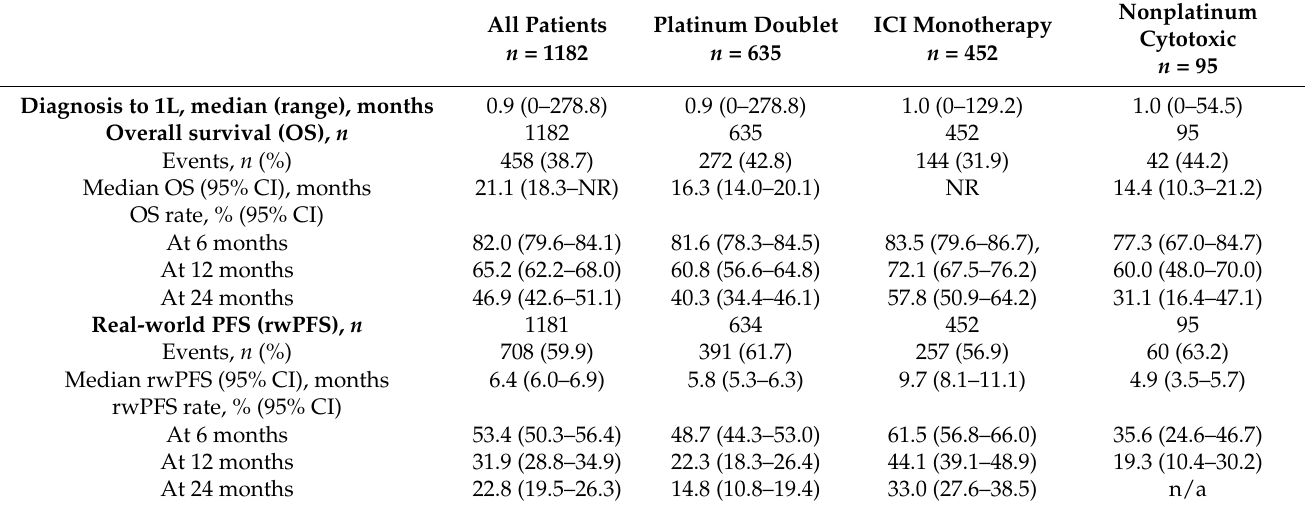
Table 2. Real-world clinical outcomes by first-line treatment